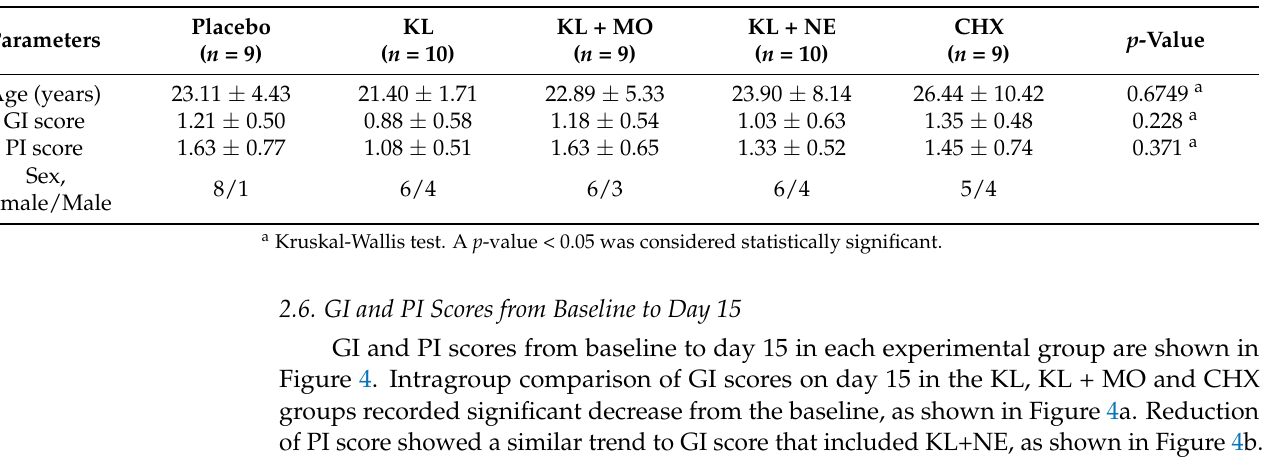
Table 3. The characteristics data of subjects and baseline clinical parameters (mean ± SD).